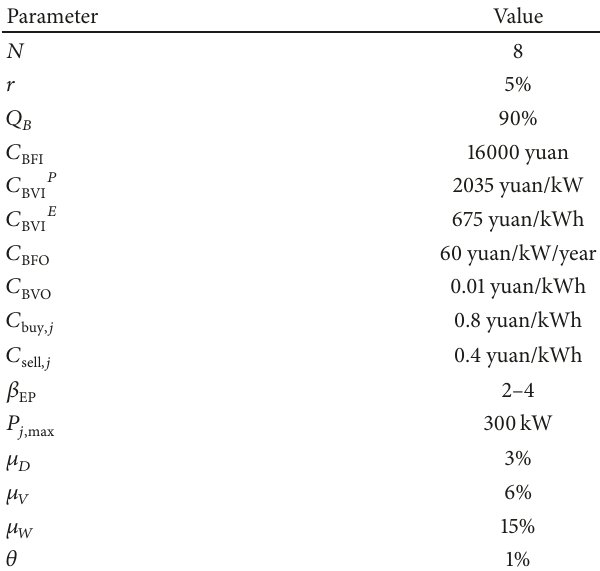
Table 2: Parameter values of the